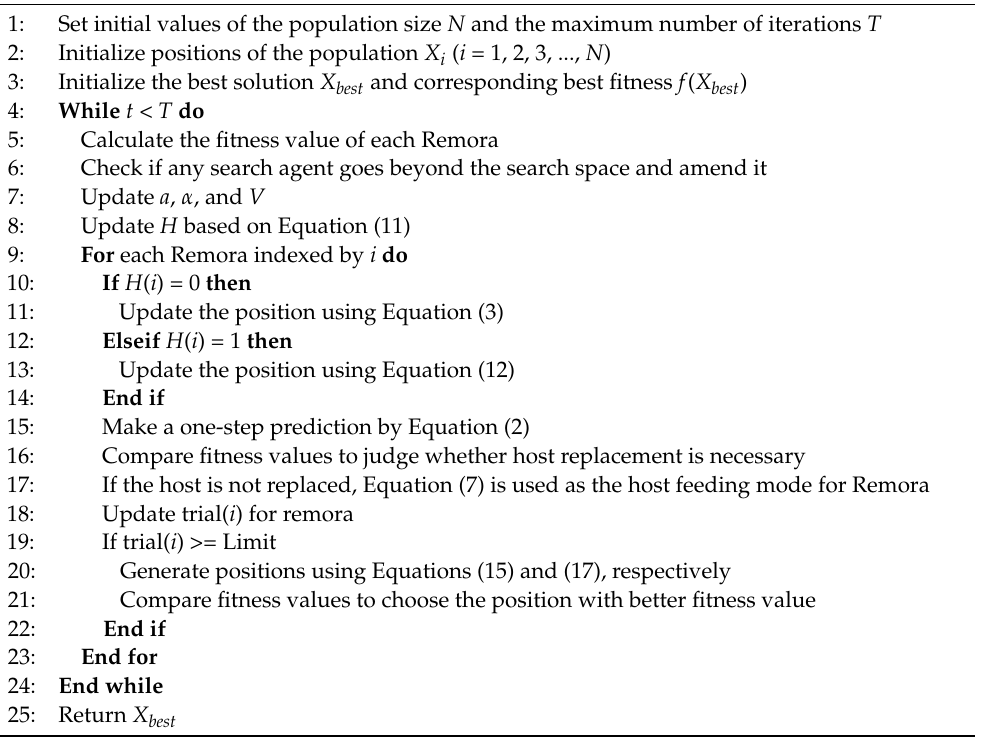
Algorithm 2 Pseudo-code of